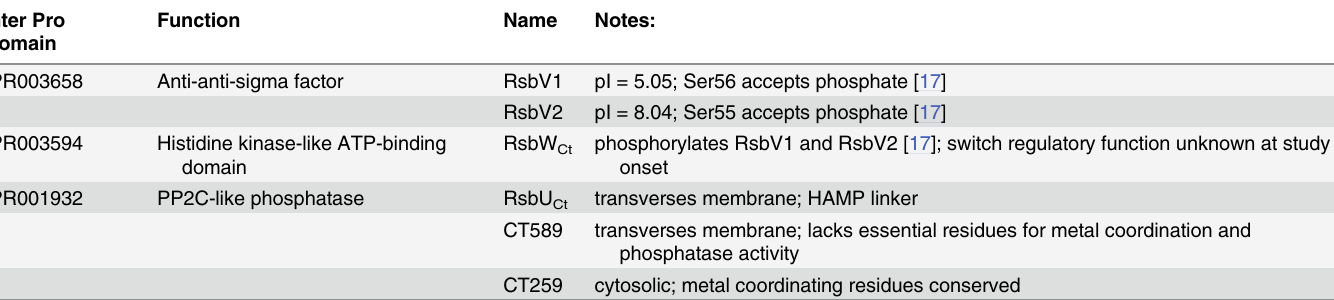
Table 1. Rsb analogues in the Chlamydiaceae